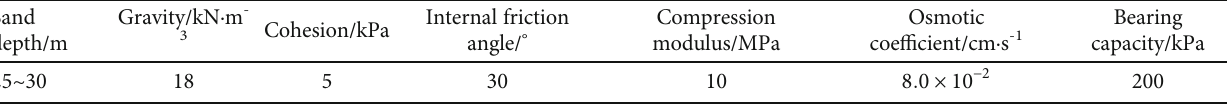
Table 1: Basic physical indexes of calcareous sand in a certain area of Sansha City.